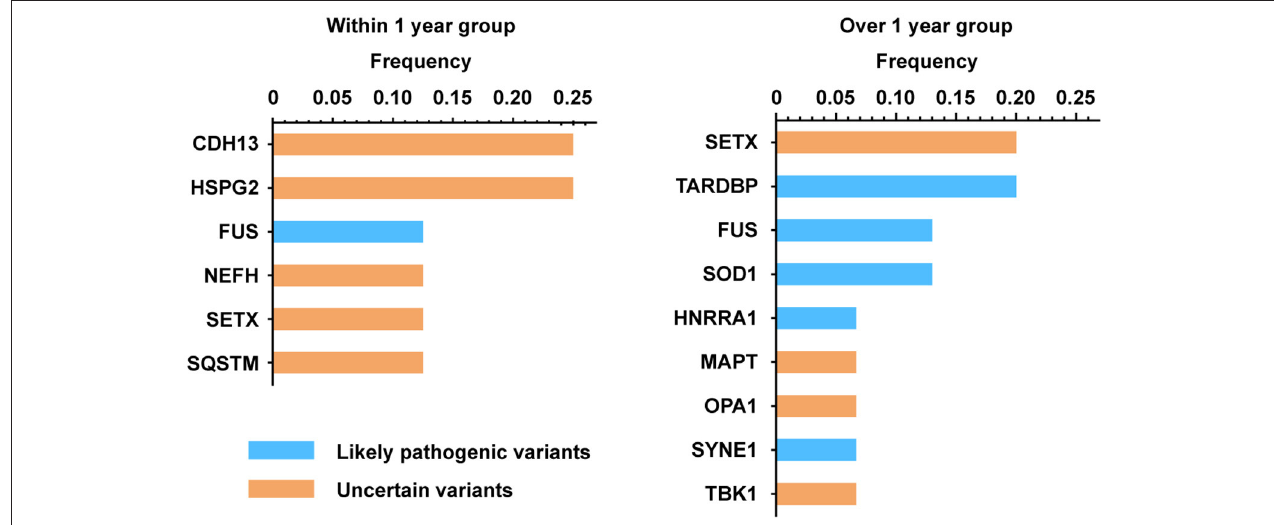
FIGURE 1 | The percentage of patients with ALS at childbearing age carrying gene mutations.